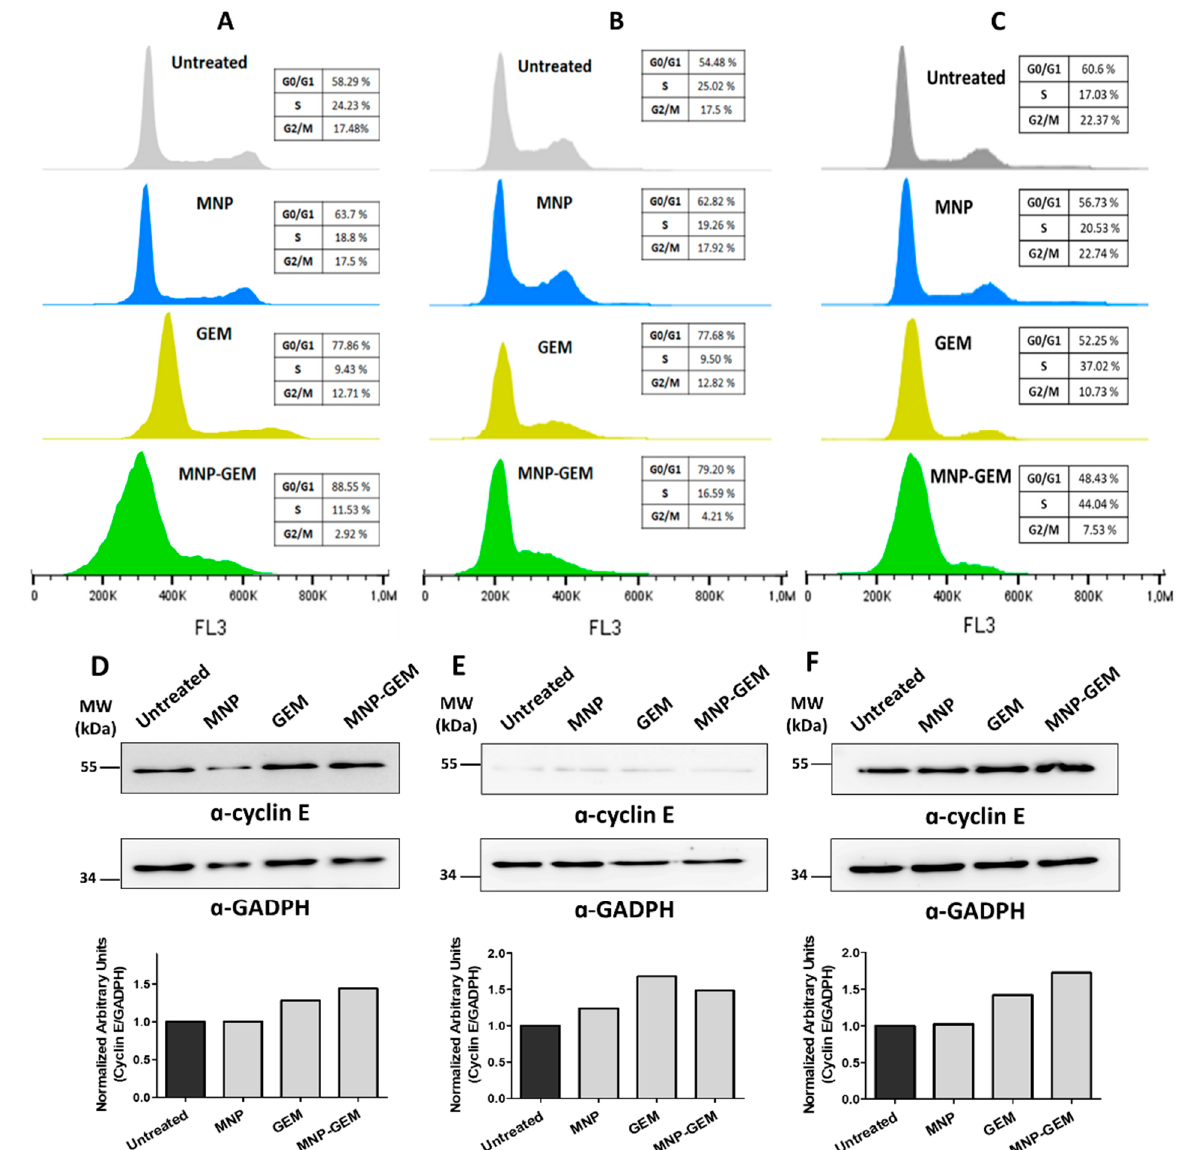
Figure 3. Flow cytometry analysis of the cell cycle 48 h after treatment in: ( A ) PANC-1; ( B ) BxPC-3; ( C ) MIA Paca-2. Analysis of cyclin E protein levels in: ( D ) PANC-1; ( E ) BxPC-3; ( F ), and MIA Paca-2. Densitometry analysis plots show arbitrary units calculated as cyclin E signal normalized to GADPH signal. Conditions for ( A , D ): MNP 0.5 mg Fe/mL, GEM 22.5 μ M, MNP-GEM 0.5 mg Fe/mL 22.5 μ M; ( B , C , E , F ): MNP 0.1 mg Fe/mL, GEM 4.5 μ M, MNP-GEM 0.1 mg Fe/mL 4.5 μ M.